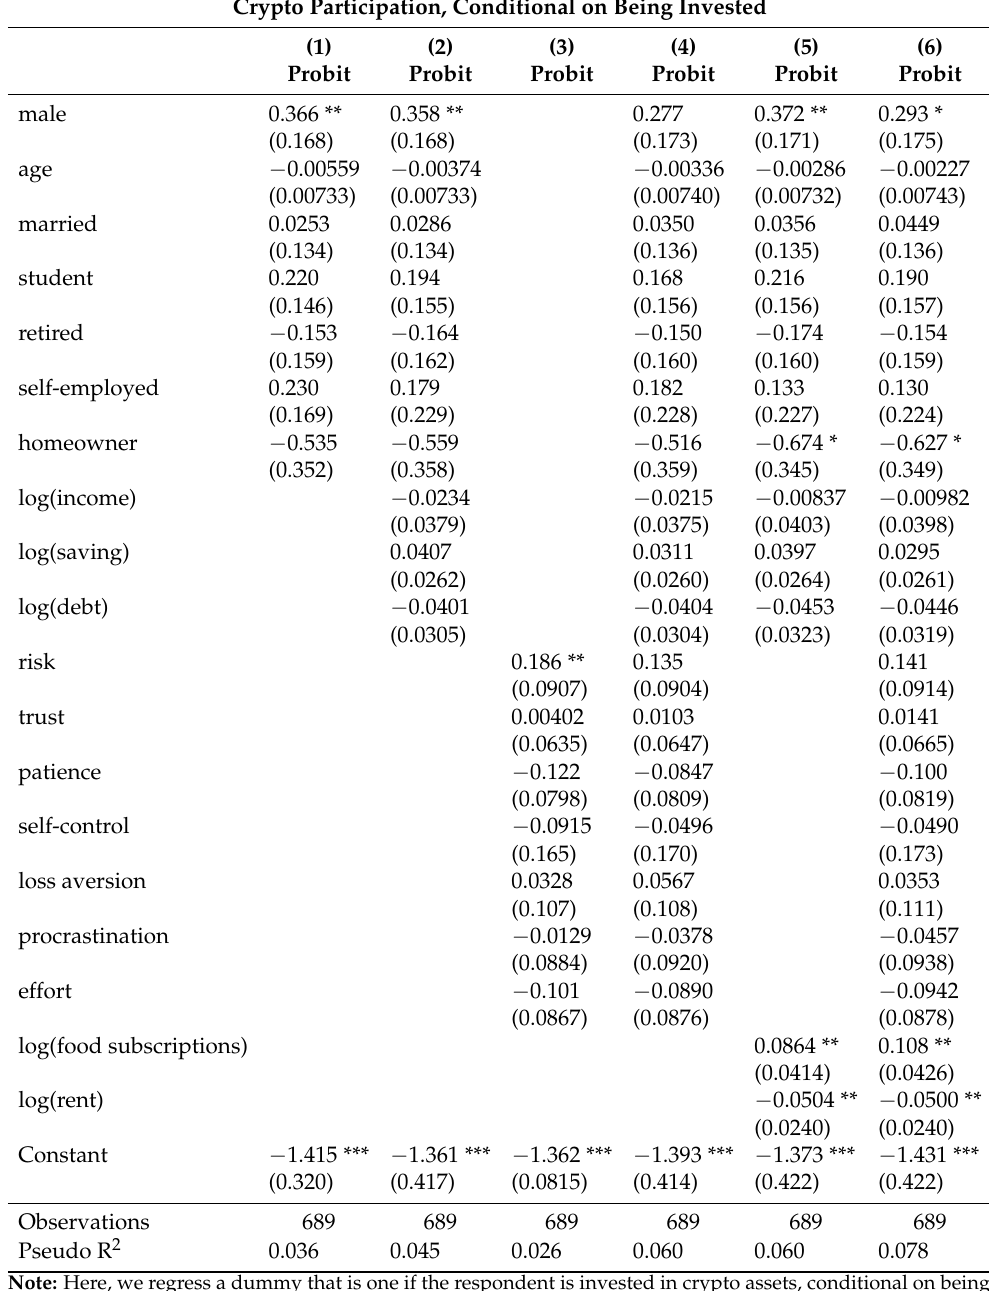
Table A9. Probit regression of crypto participation, conditional on being invested. Source: Own data. Crypto Participation, Conditional on Being